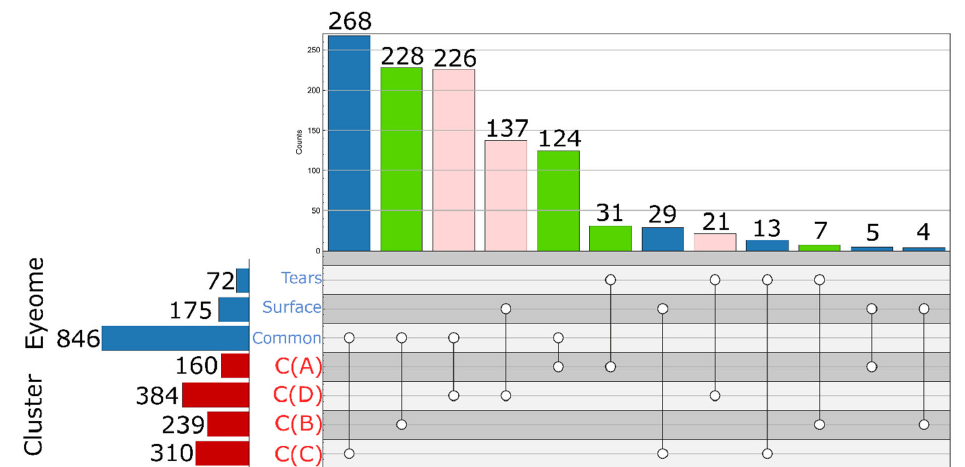
Figure 5. Count plot representation of the intersections of protein clusters and sections of the EyeOME [13] database. Clusters are those identified in Section 2.4. Proteins in the ‘Cornea’ or ’Sclera’ section of EyeOME were classified as Surface.